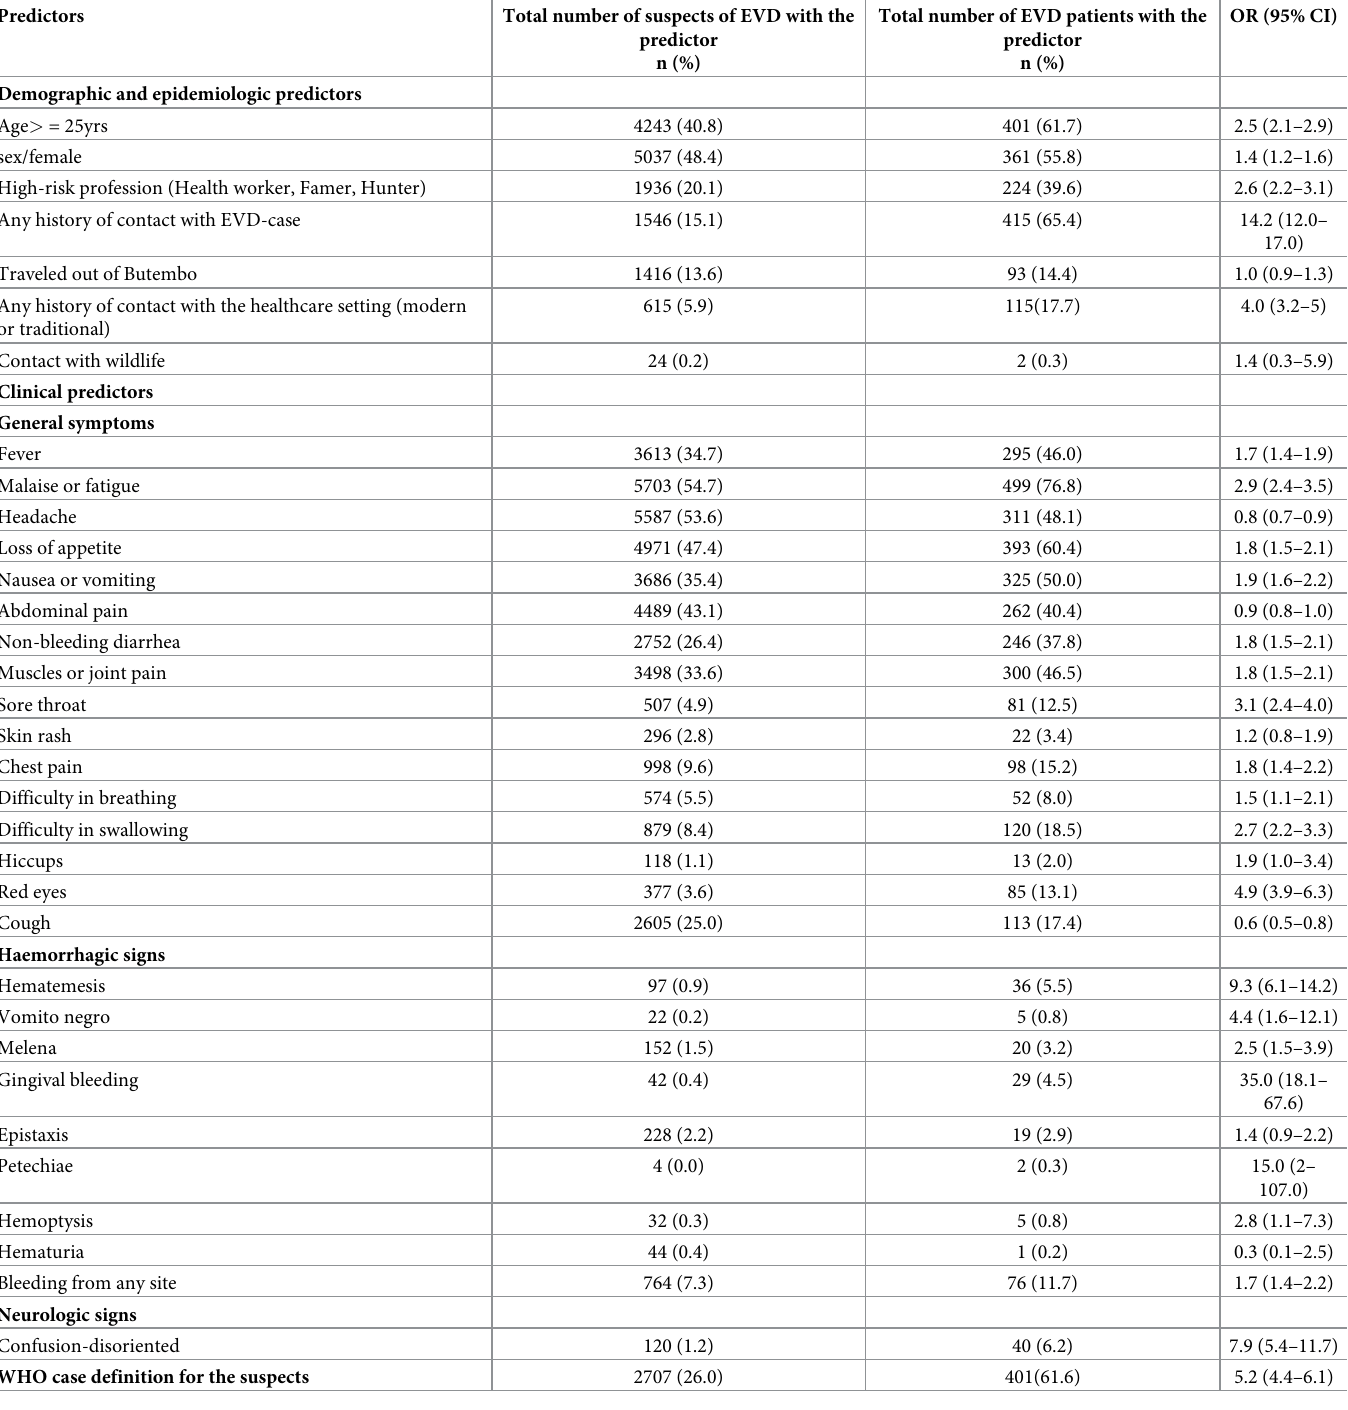
Table 1. Epidemiological and clinical characteristics of the included